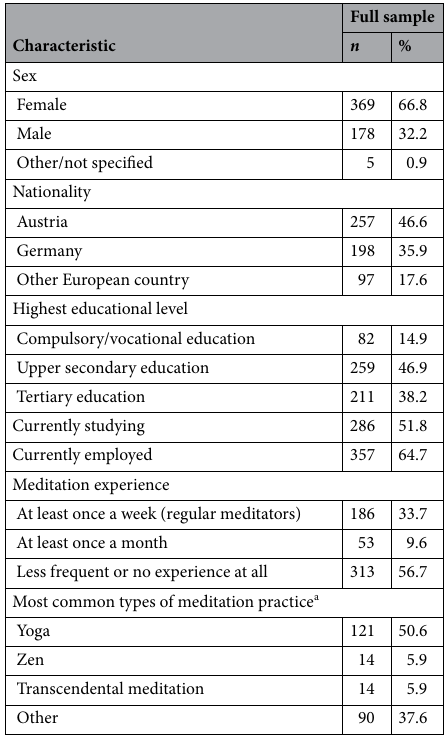
Table 1. Sample characteristics. N = 552 German speaking adults. a Among all participants meditating at least once a month ( n =